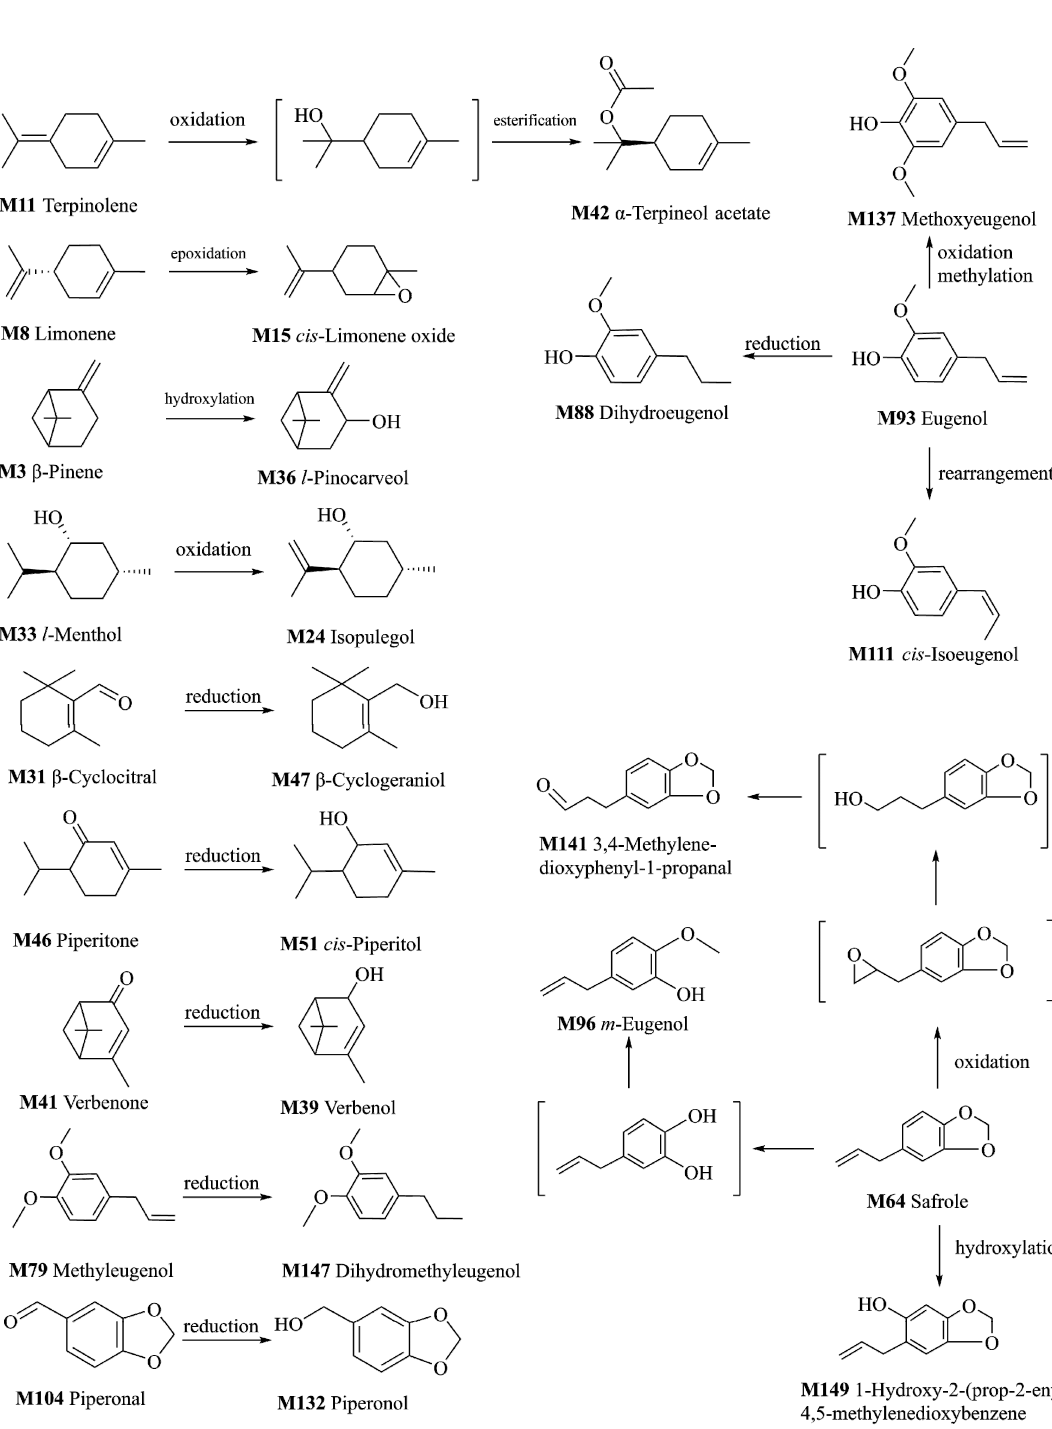
Figure 4. Proposed metabolic pathways of some volatile constituents of ARR.